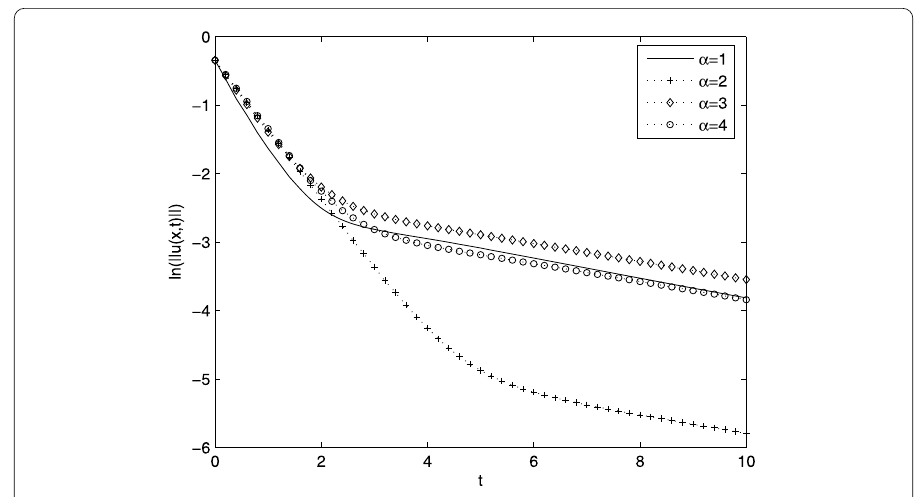
Figure 6 The natural logarithm of the L 2 -norm of u ( x , t ), ln( (cid:7) u ( x , t ) (cid:7) ), versus time for various values of α when using the first nonlinear non-adaptive control law; v = 0.01, μ = 0.001, γ 1 , γ 2 = 0.0005 and u 0 ( x ) = sin(2 π x